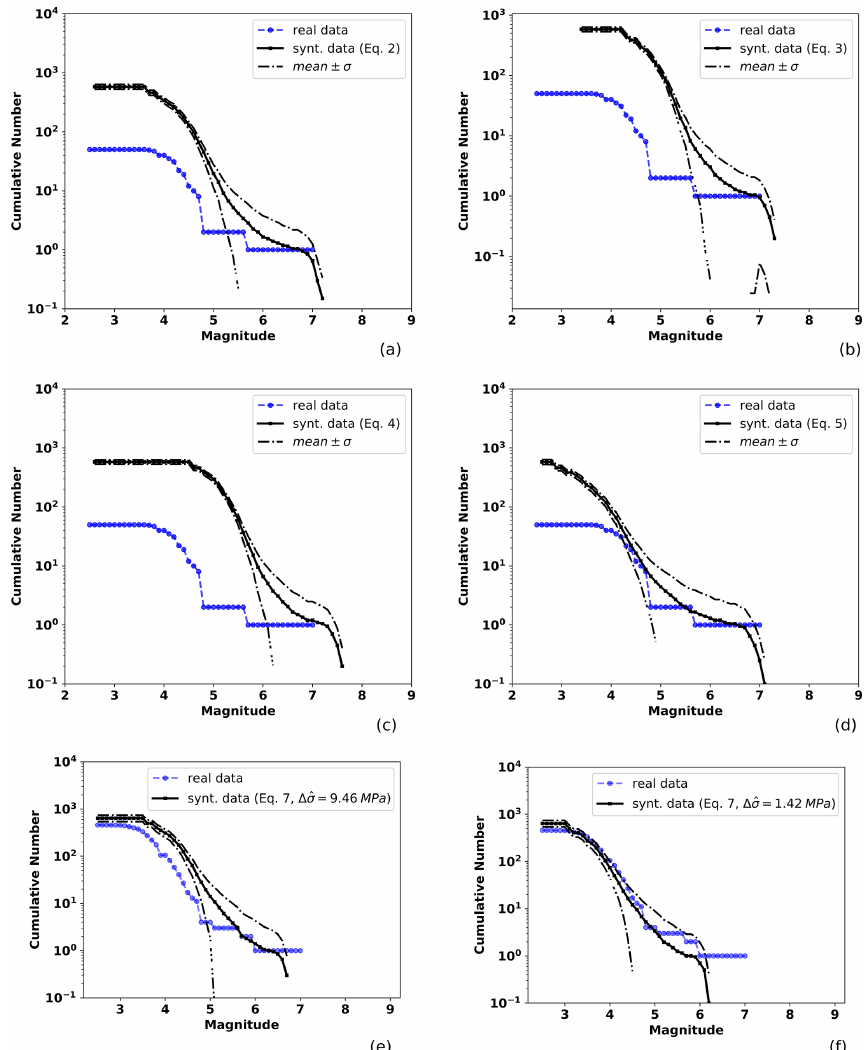
Figure 5. Observed and TREMOL synthetic frequency–magnitude curves for SA region 2 (Table 1). The solid black line indicates the mean after 20 realizations and the broken lines the standard deviation. The blue line is the seismicity curve for events from 1988 to half a year before the mainshock date (25 February 1996), including earthquakes that occurred at the depth range mentioned in the text. Other features as in Fig.